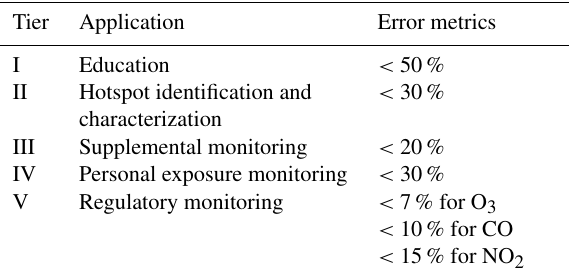
Table 2. EPA air quality sensor performance guidelines for various applications. Reproduced from Williams et al. (2014).